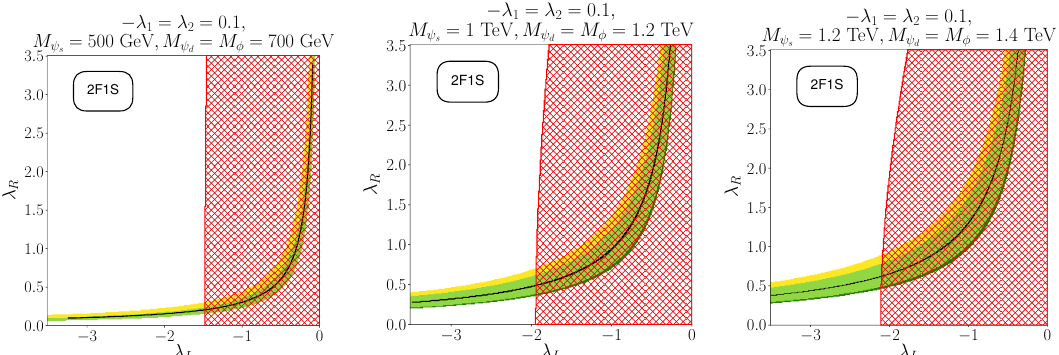
Figure 12. Results from Model 2F1S, scanning over the couplings of the new fermions and scalar to the left- and right-handed muon. Colours are the same as in figure 9. The mixing couplings are fixed to − λ = λ = 0 . 1 . In this scenario the masses of the scalar doublet φ 1 2 ψ d are raised by 200 GeV above the mass of the fermion singlet ψ S . Points to the right of the red line produce an over abundance of dark matter and are strongly